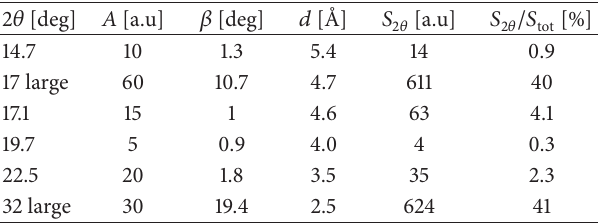
Table 3: Parameters of XRD spectrum of the starch heated 2 hours at 140 ∘ C.